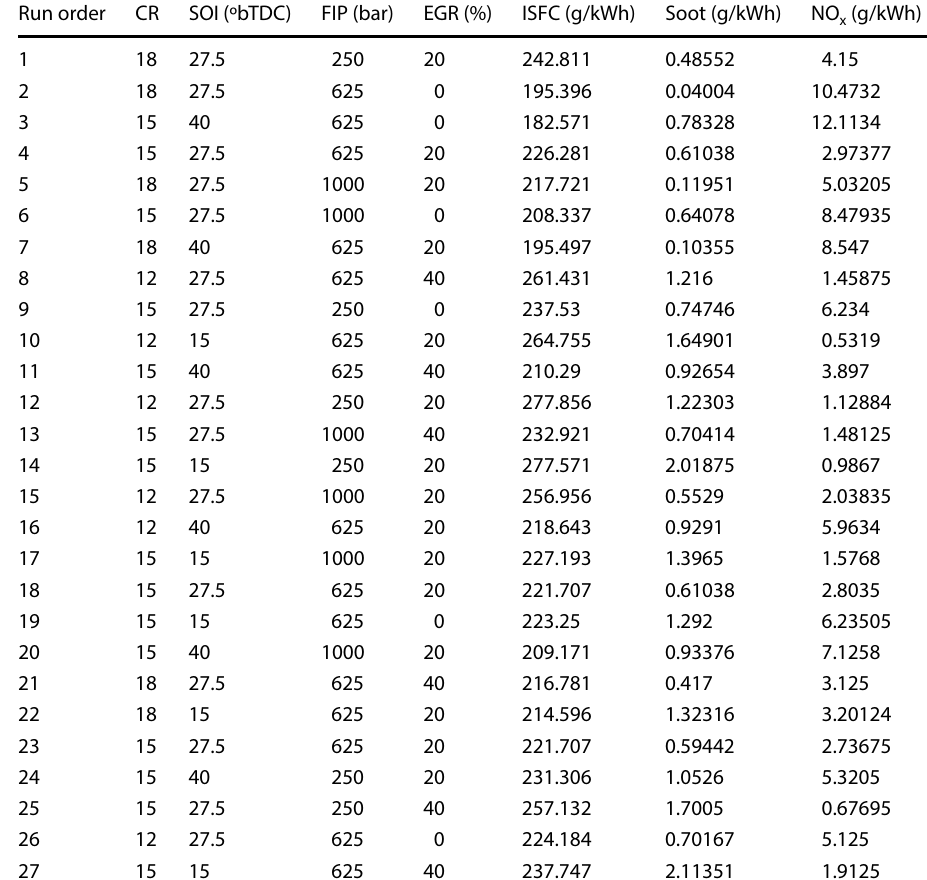
Table 3 Experimental design and their responses for VCR diesel